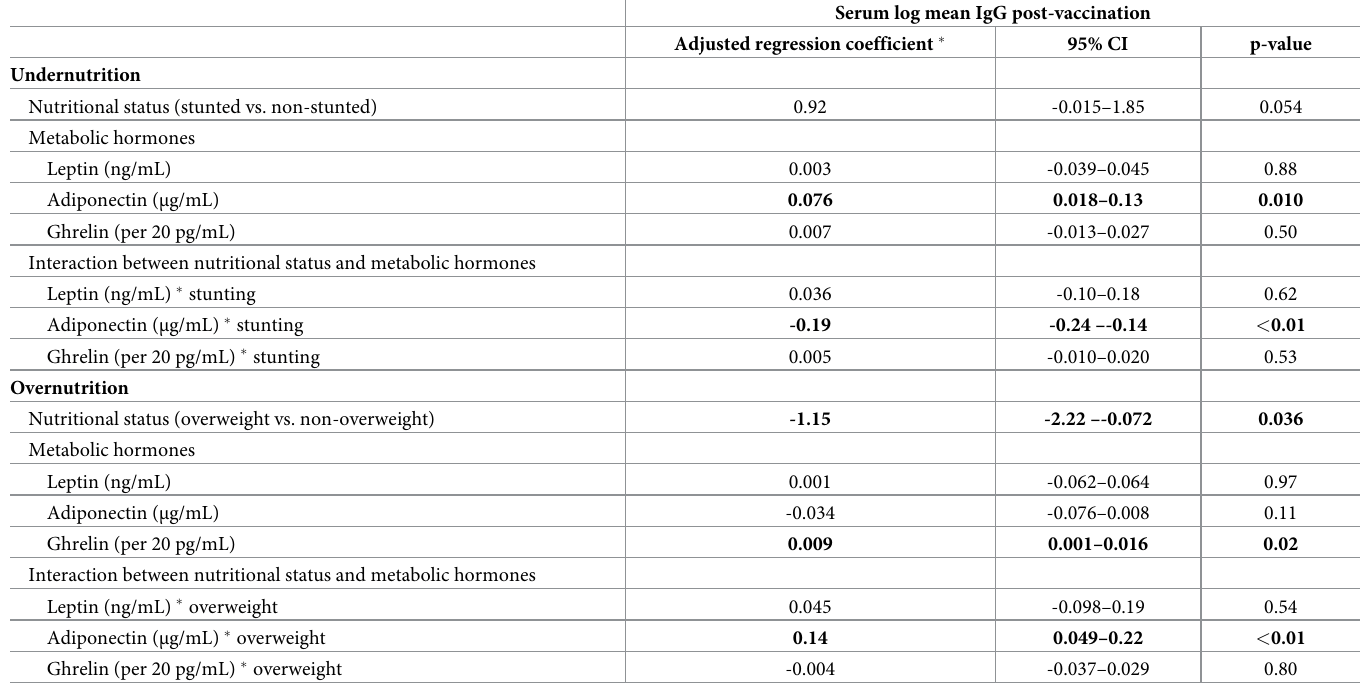
Table 3. Results from multivariable linear GEE models for post-PCV13 serum antibody levels in stunted and overweight